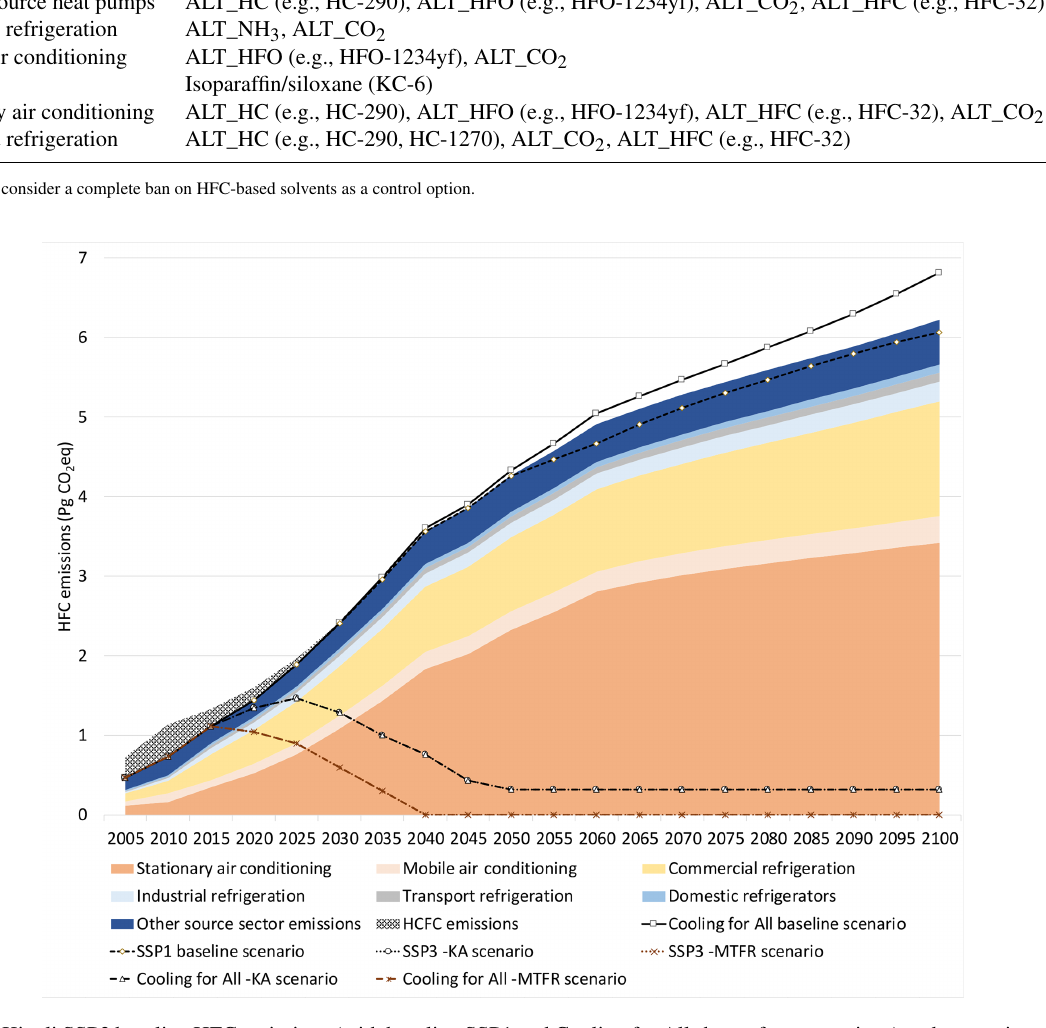
Figure 1. Pre-Kigali SSP3 baseline HFC emissions (with baseline SSP1 and Cooling for All shown for comparison) and respective alternative scenarios (Kigali Amendment – KA and Maximum technically feasible reduction – MTFR). Note that Cooling for All -KA and Cooling for All -MTFR scenarios are not visible due to the small differences in mitigation scenarios to SSP3-KA and